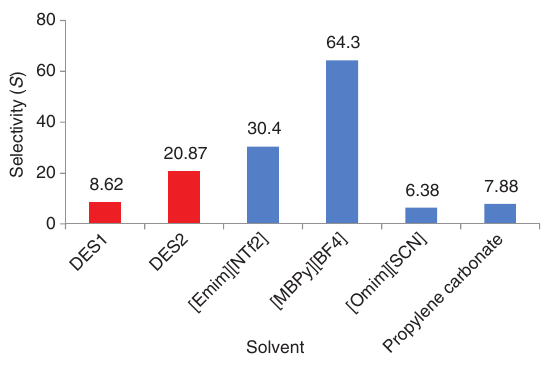
Figure 5: The selectivity obtained in this work compared with the selectivity reported for other solvents for the same system.